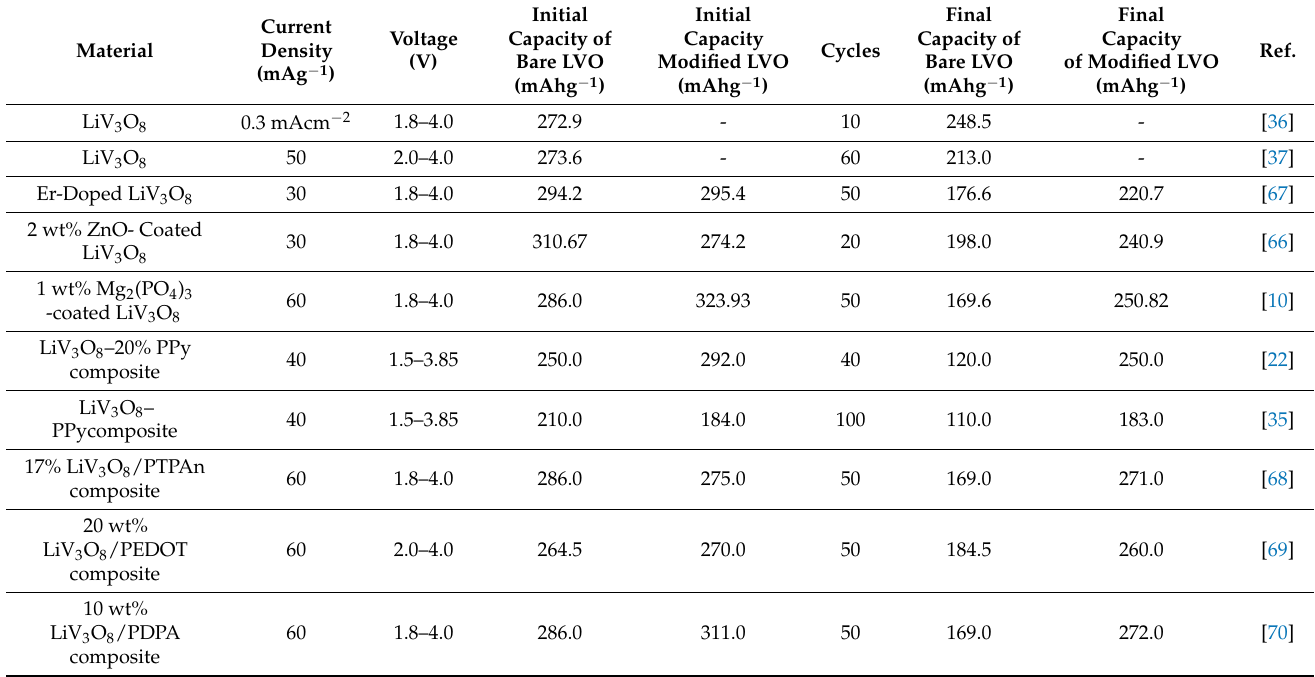
Table 2. Comparison between the electrochemical properties of bare and modified LiV 3 O 8